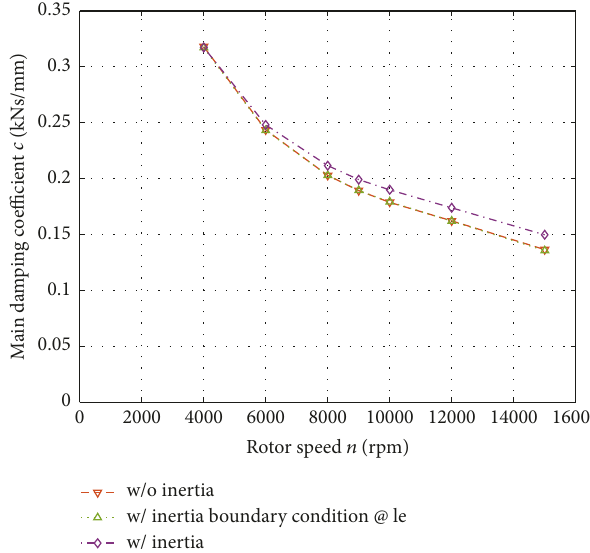
Figure 18: Comparison of predicted synchronous main bearing damping for different simulation boundary conditions (TPB120, 𝑝 = 2.0 MPa, 𝑄 = 90 l/min, 𝑇 𝑞 𝑘 = 0.8 kN/mm). pivot